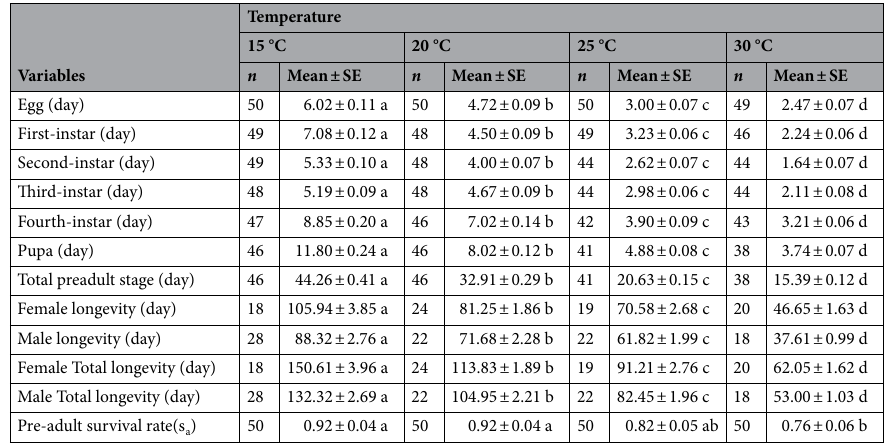
Table 1. Duration of each stage and preadult survival rate (Mean ± SE) of Harmonia axyridis on Spodoptera litura eggs at four different temperatures. Standard errors were estimated by using the bootstrap technique with 100,000 resampling. Difference was compared using the paired bootstrap test ( P < 0.05). The means within a row followed by a different letter indicate significant differences among the